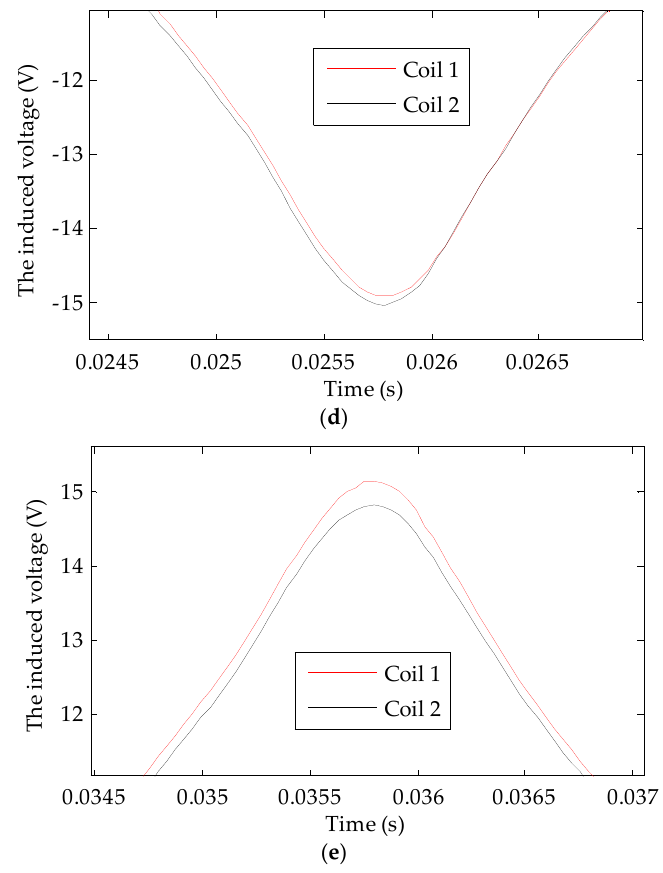
Figure 10. Induced voltage curves for both detection coils at a dynamic eccentricity of 45° with rated load: ( a ) global map; ( b ) local map 1; ( c ) local map 2; ( d ) local map 3; ( e ) local map 4. By using the induced voltage of a single detection coil as an example, a Fourier decomposition was performed and the resulting spectrum is shown in Figure 11.